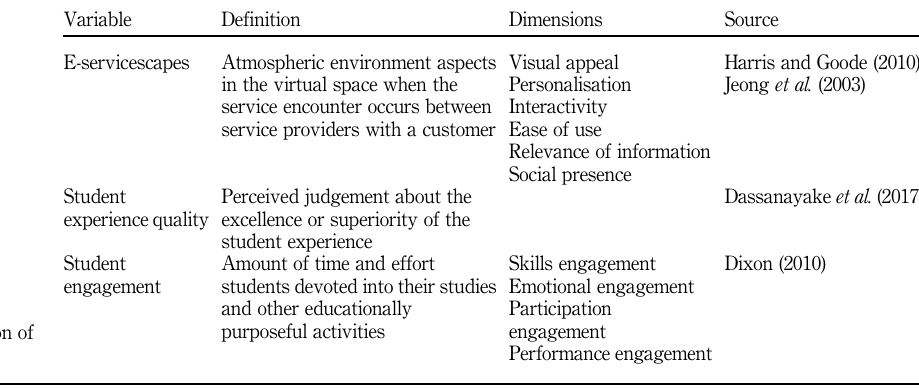
Table I. Operationalisation of study